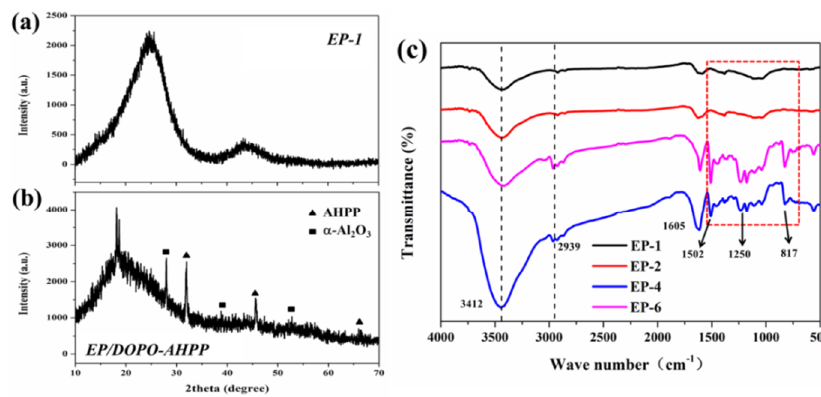
11 of 15 Figure 6. Photographs and Raman spectra of the char residue from pristine EP ( a , e ), EP/DOPO ( b , f ), EP/DOPO-AHPP ( c , g ), and EP-AHPP ( d , h ) after cone calorimeter tests.